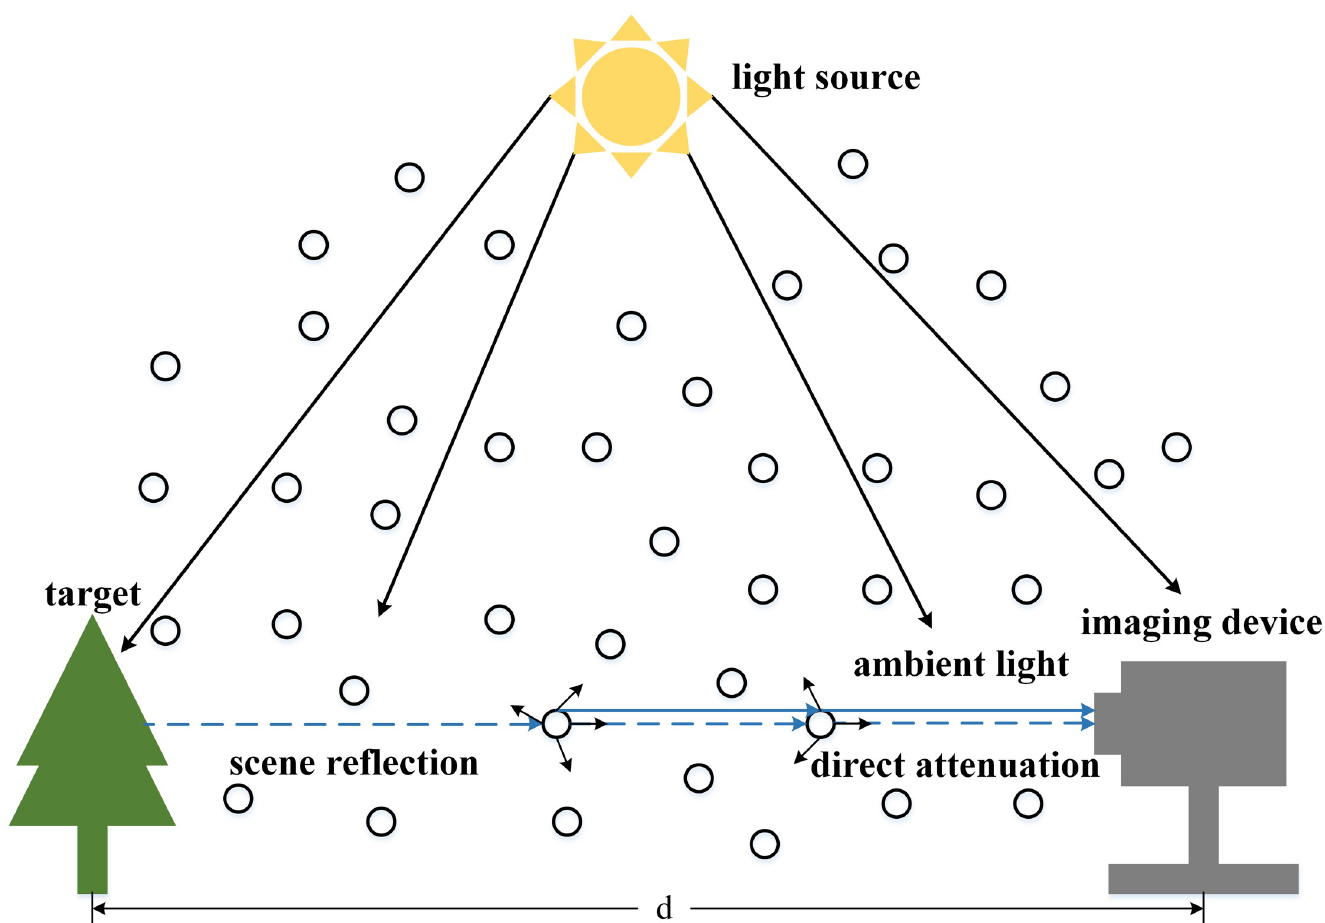
Fig 1. The imaging process using the atmospheric single scattering model, which ignores the multiple scattering of light in the atmosphere, but only considers the single scattering of light in the atmosphere.